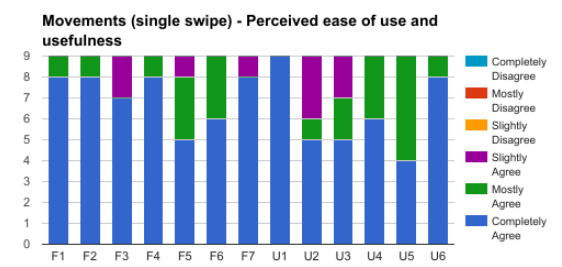
Fig. 8. T1 Movements (swipe) - Perceived ease of use and usefulness